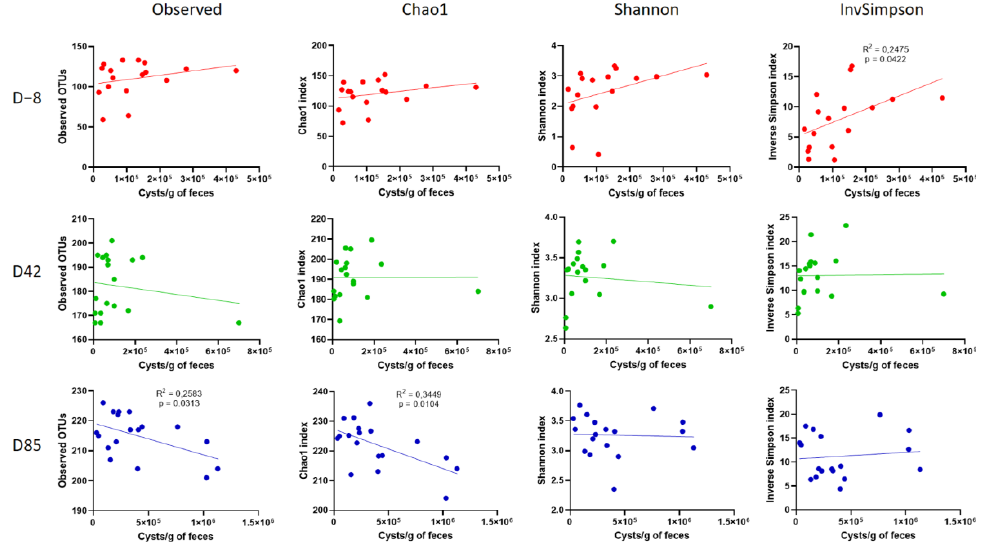
Figure 7. Correlation between alpha diversity measures and G. intestinalis cysts shedding in D−8 samples (red), D42 samples (green), and D85 samples (blue). The correlation was determined using Pearson’s coefficient.